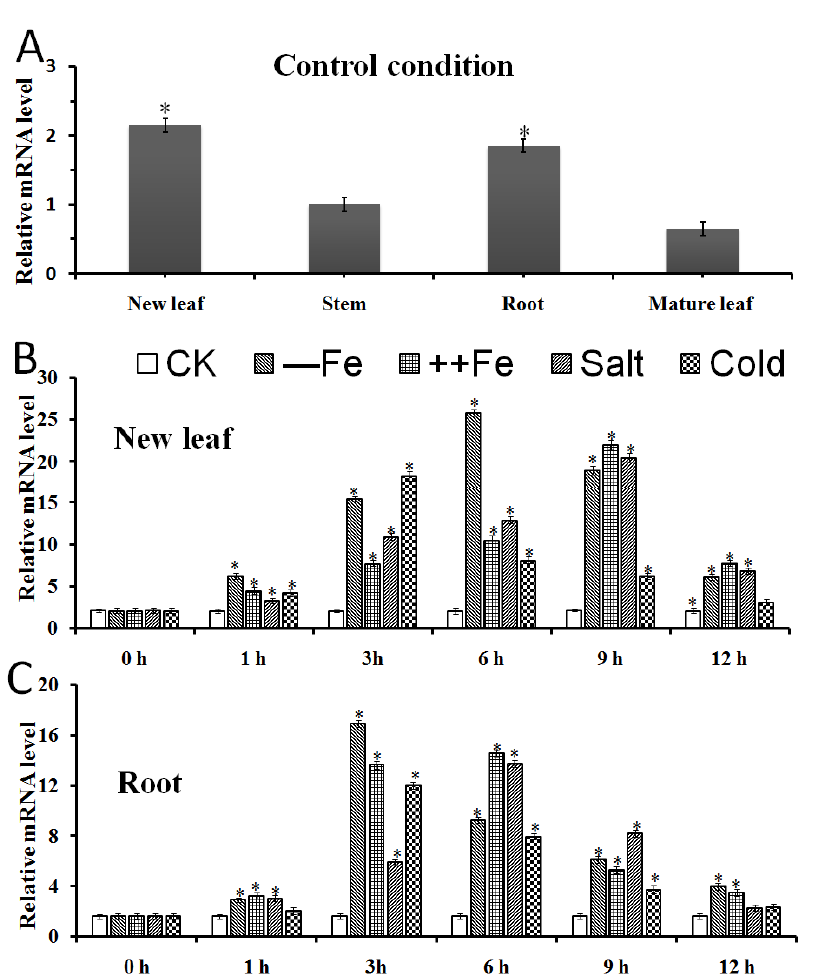
Figure 3. Expression patterns of MxbHLH18 in different organs and quantitative real-time PCR results of responses to different stresses in M. xiaojinensis . ( A ) Under control conditions (40 μ M Fe-EDTA), the expression level of MxbHLH18 in roots, stems and leaves (new and mature leaves). The asterisk above the column represents a significant difference compared with the expression in the mature leaf (* p ≤ 0.05). ( B , C ) Under control condition (CK), low concentration iron (4 μ M Fe-EDTA, ––Fe), high concentration iron (160 μ M Fe-EDTA, ++Fe), low temperature (2 °C) and salt stress (200 mM NaCl), the expression level of MxbHLH18 gene in new leaves and roots. The data represent the mean and standard error of three repetitions. The asterisk on the column indicates that the expression level is significantly different from that under the control condition (* p ≤ 0.05).